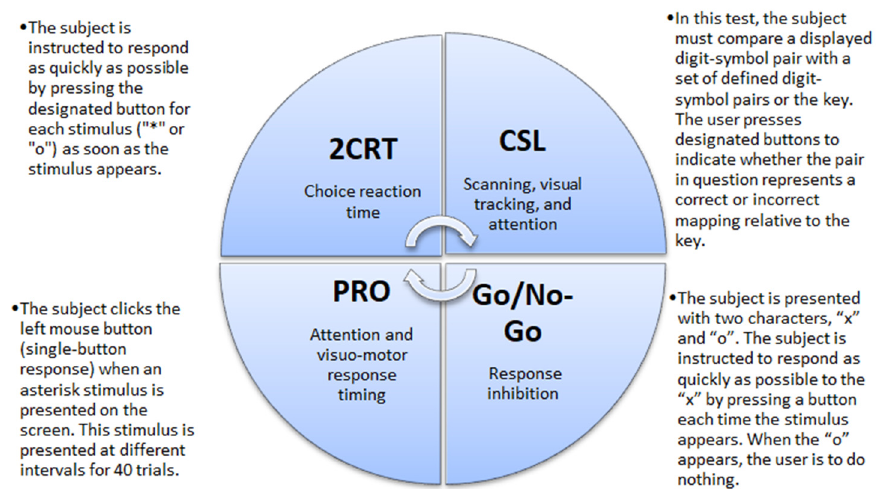
Figure 1. Descriptions of the cognitive tests. 2CRT—2-Choice Reaction Time test; CSL—Code Substitution–Learning, PRO—Simple Reaction Time.